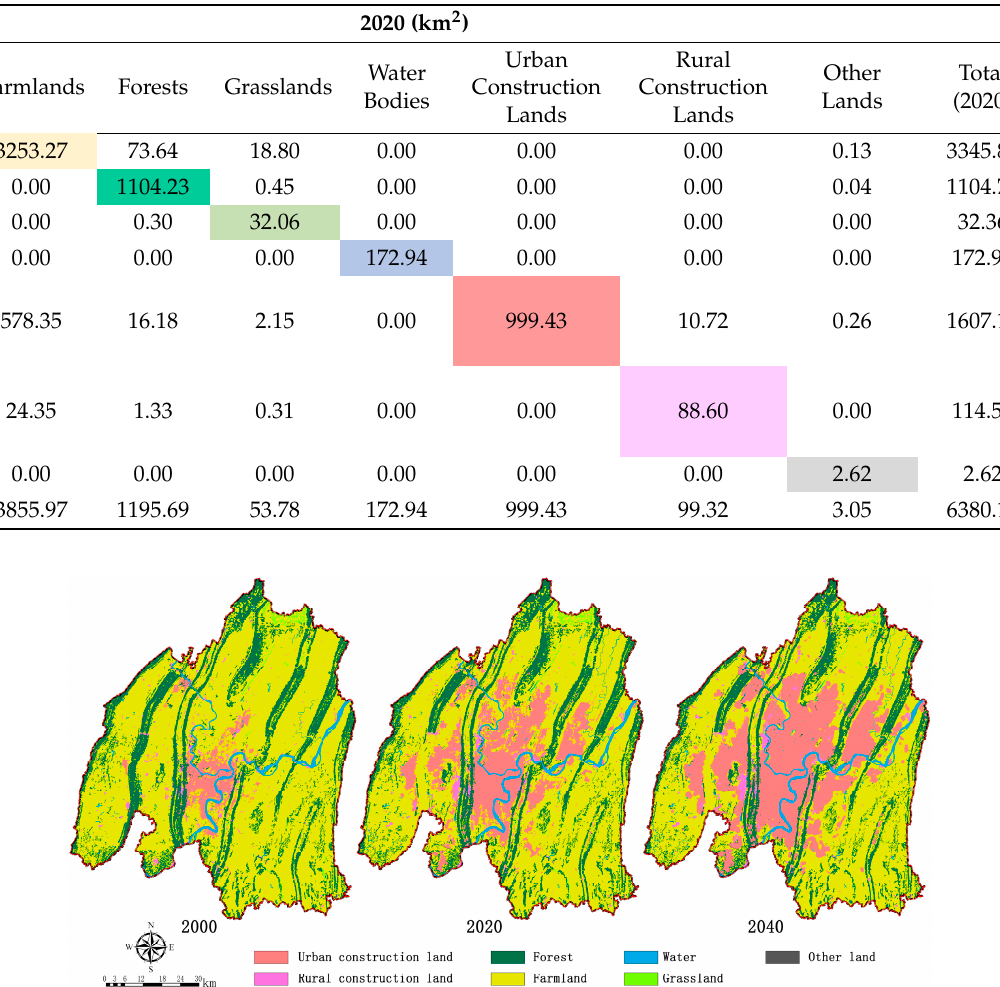
Table 5. Transfer matrix of land-use from 2020 to 2040.